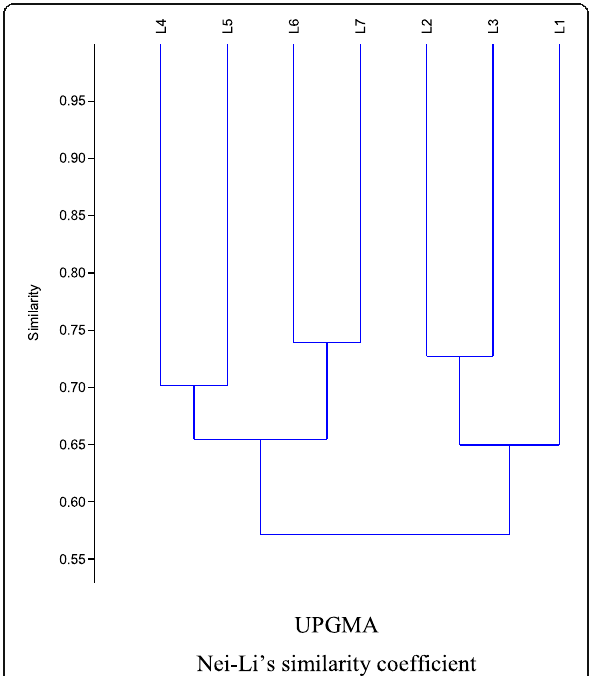
Fig. 3 Dendrogram representing the genetic relationship among the seven rice lines using UPGMA cluster analysis of Nei-Li ’ s similarity coefficient generated from ISSR